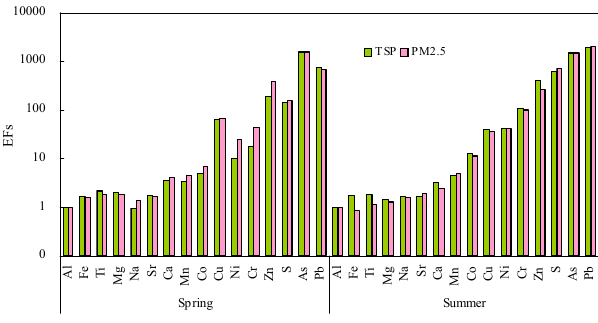
Fig. 3. Enrichment factors (EFs) of elements at MT in spring and summer, 2006.